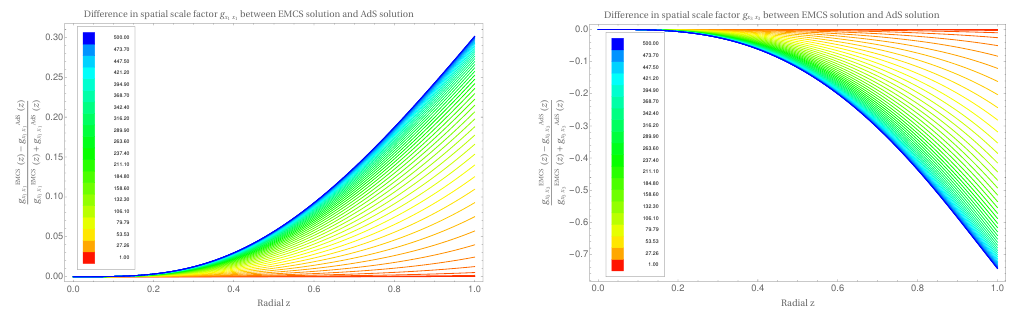
Figure 4 . Deviations of the charged magnetic black brane geometry from its near-boundary asymp- totically AdS limit. We display the relative difference between the spatial scale factors g x g x to full solutions to Einstein-Maxwell-Chern-Simons theory and the empty AdS solutions. The 3 x 3 inset legend displays the coloring for different values of B/T 2 . The difference between these space- times can be seen to be very large deep in the bulk as we move towards B/T 2 (cid:29) 1 . for the remaining plots in this section.